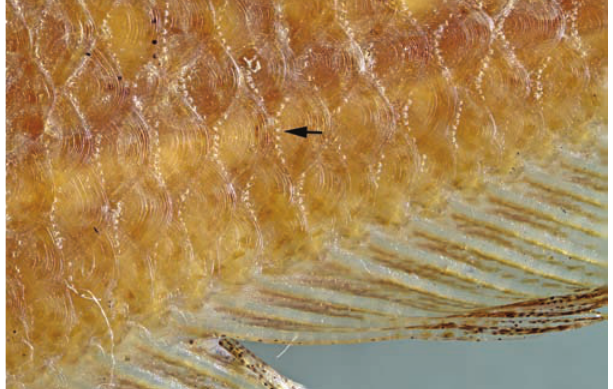
Fig. 3. Humeral spot distance as a function of standard length for species of Charax.